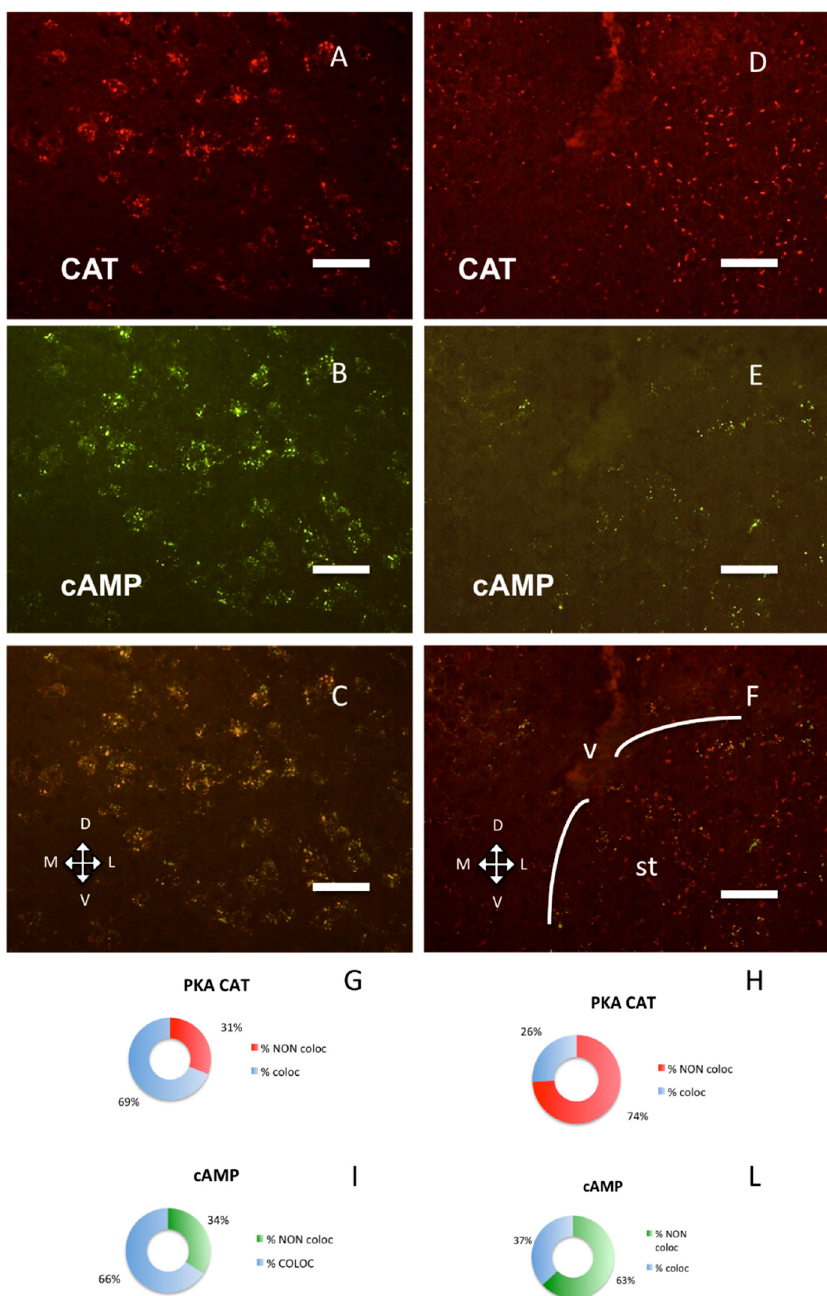
Figure 4. PKA catalytic subunit in the amygdala and stria terminalis, coronal sections, dorsal on the top. Scale bar, 25 µ m. ( A ) Catalytic subunit immunolabeling in the basolateral nuclei of amygdala. ( B ) Same field, Alexa488-cAMP. ( C ) Merge of A and B . ( D ) Catalytic subunit immunolabeling in the bed nuclei of the stria terminalis. ( E ) Alexa488-cAMP in the same field. ( F ) Merge of D and E ; v: lateral ventricle. The white lines enclose the bed nucleus of the stria terminalis (st). G – I : quantification of superimposition in C ( n = 1559). ( G ) Percentage of colocalization of PKA catalytic immunolabeling (% coloc, light blue, n = 528) or not (% NON coloc, red, n = 237) with cAMP in C . H – L : quantification of superimposition in F ( n = 679). ( H ) Percentage of colocalization of PKA catalytic immunolabeling (% coloc, light blue, n = 118) or not (% NON coloc, red, 311) with cAMP in F . ( I ) Percentage of colocalization of cAMP (% coloc, light blue, n = 523) or not (% NON coloc, green, n = 271) with PKA catalytic immunolabeling in C. ( L ) Percentage of colocalization of cAMP (% coloc, light blue, n = 92) or not (% NON coloc, green, n = 158) with PKA catalytic immunolabeling in F .